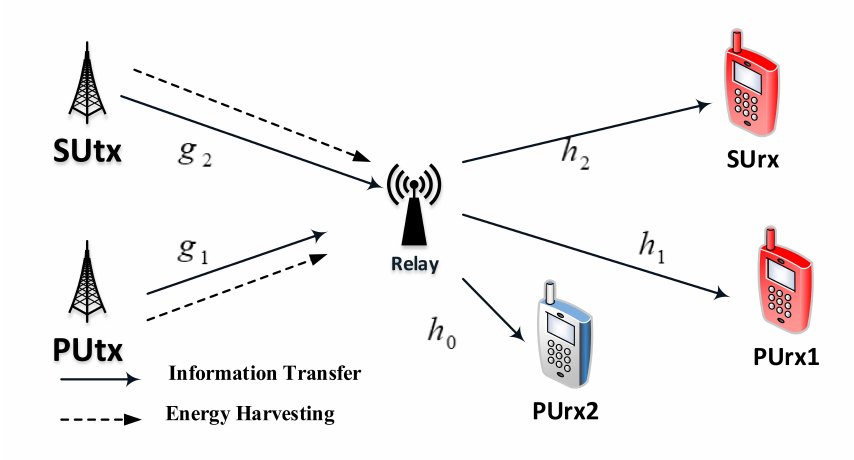
Figure 1. Scheme 1: System model of EH assisted CR-NOMA network.